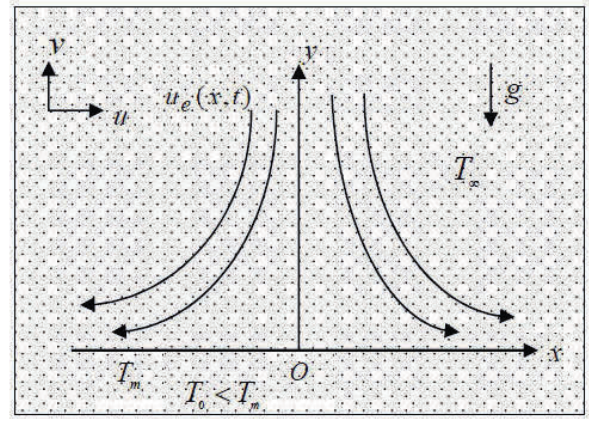
Fig. 1: The physical model and coordinate